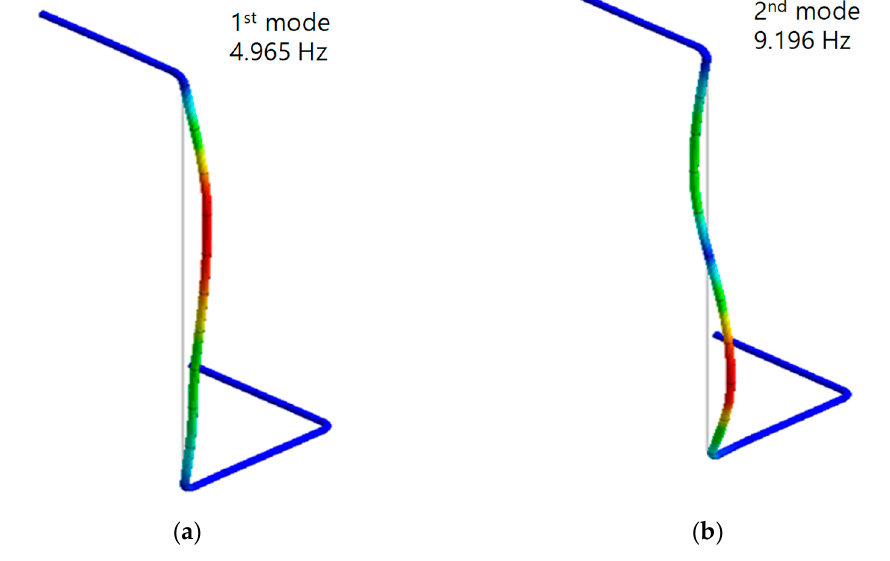
Figure 9. Natural frequency and mode shape of the piping system: ( a ) 1st mode; ( b ) 2nd mode.